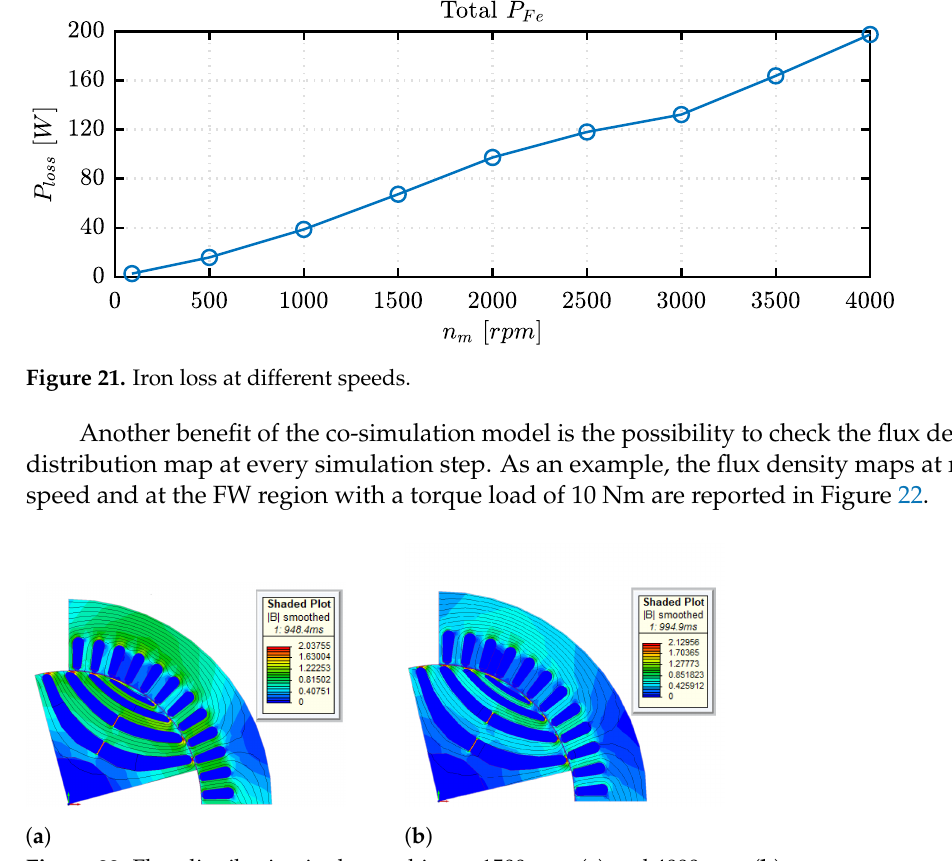
Figure 22. Flux distribution in the machine at 1500 rpm ( a ) and 4000 rpm ( b ).